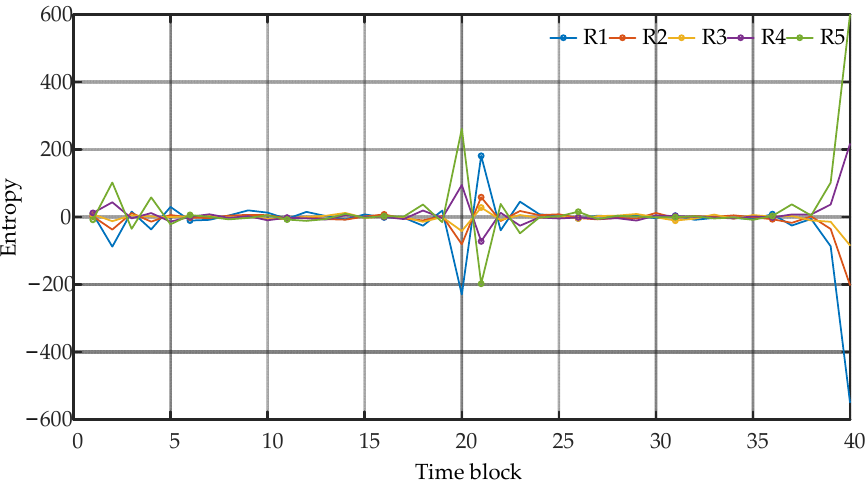
Figure 4. Flow chart of wavelet energy entropy method.